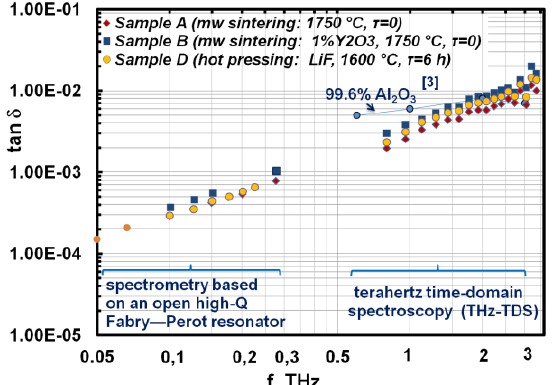
Fig. 2. The frequency dependencies of the dielectric loss tangent of MgAl 2 O 4